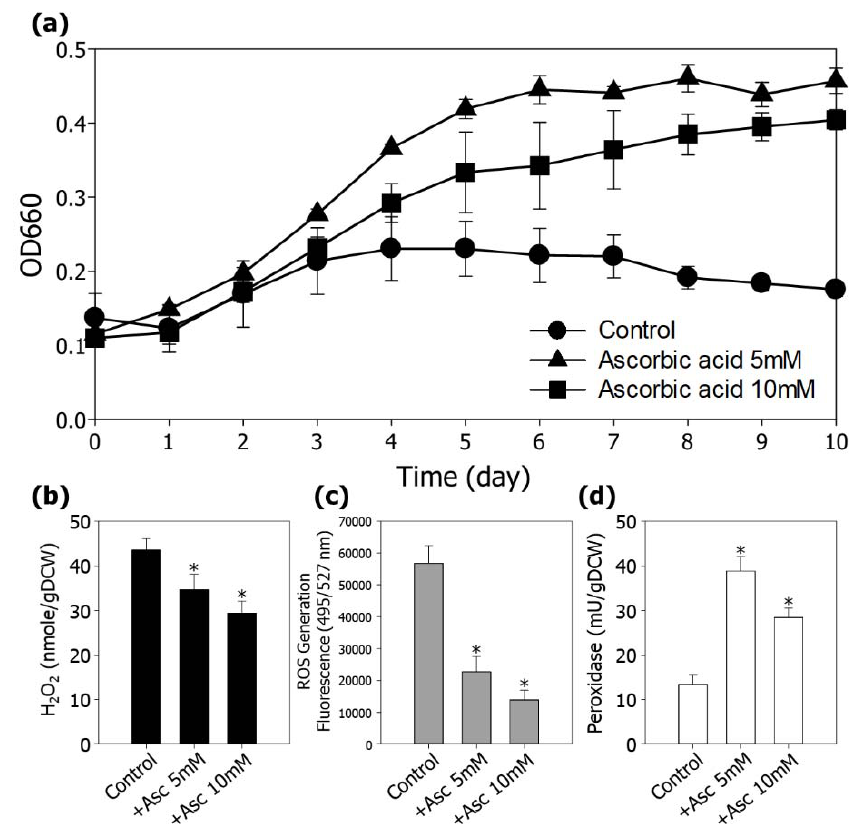
Figure 3. Effects of ascorbic acid on MES in R. sphaeroides . ( a ) Cell growth in the presence of 5 mM or 10 mM ascorbic acid. The cultivations were conducted in MES reactors using CO 2 as a carbon source and electricity as a reducing source under –0.6 V (vs. Ag/AgCl). Circle lines indicate control (untreated ascorbic acid). Upward triangle lines indicate the addition of 5 mM ascorbic acid. The square line represent the addition of 10 mM ascorbic acid. ( b ) Measurement of endogenous H 2 O 2 . ( c ) Generation of endogenous ROS. The levels of ROS were measured using CM ‐ H 2 DCFDA. The fluorescence is represented in arbitrary units and normalized by the optical density of the samples. ( d ) The analysis of peroxidase activity. Asc, ascorbic acid. Every experiment was conducted in triplicate and error bars indicate standard deviation of mean. Asterisk represents statistically significant difference, as determined by a Student’s t ‐ test (* p < 0.05).